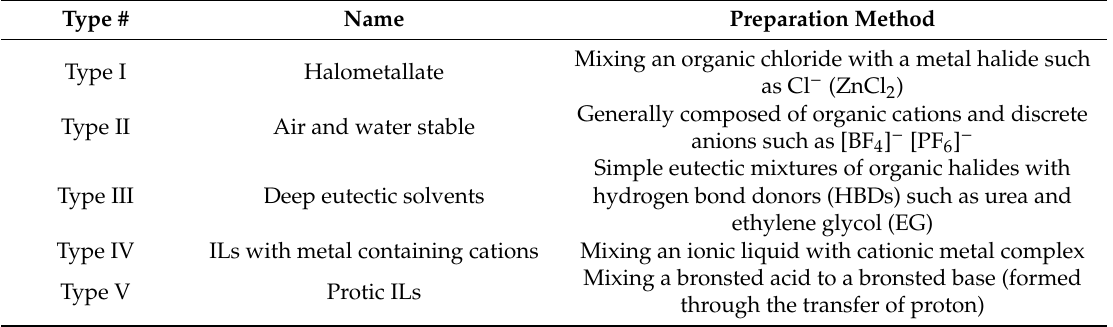
Table 1. Types of ionic liquids (ILs) employed for the deposition of zinc and zinc-based alloys